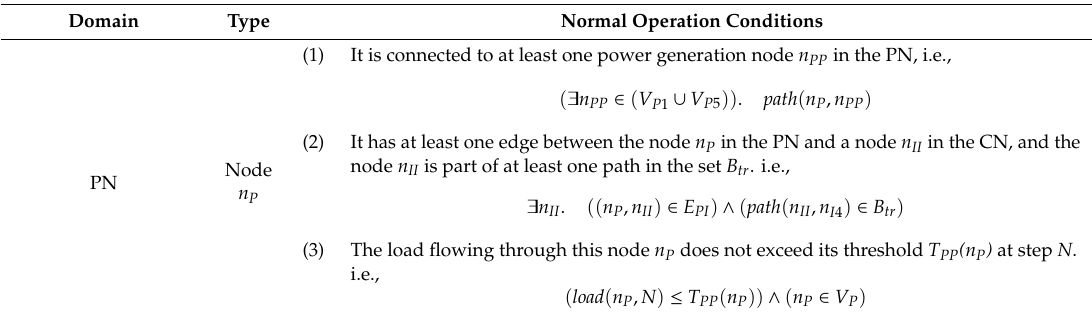
Table 2. Normal operation